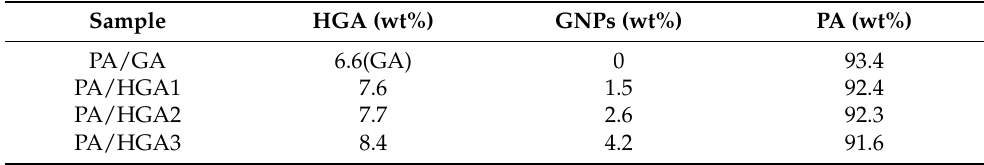
Table 1. The HGA, GNPs, and PA contents in